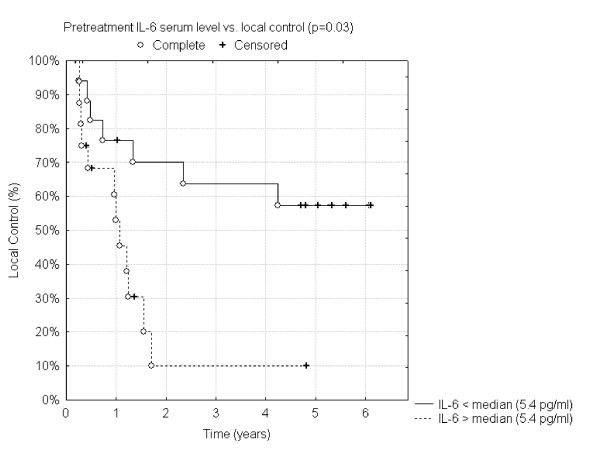
Kaplan-Meier curve local control analysis. There was a significant difference in local control between patients with pretreatment IL-6 serum levels above and below the median (9.3 vs. 70.4% at 2 years, p = 0.03).